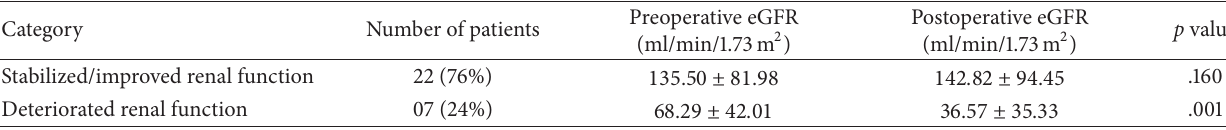
Table 3: Overall stabilized and deteriorated renal function patients.